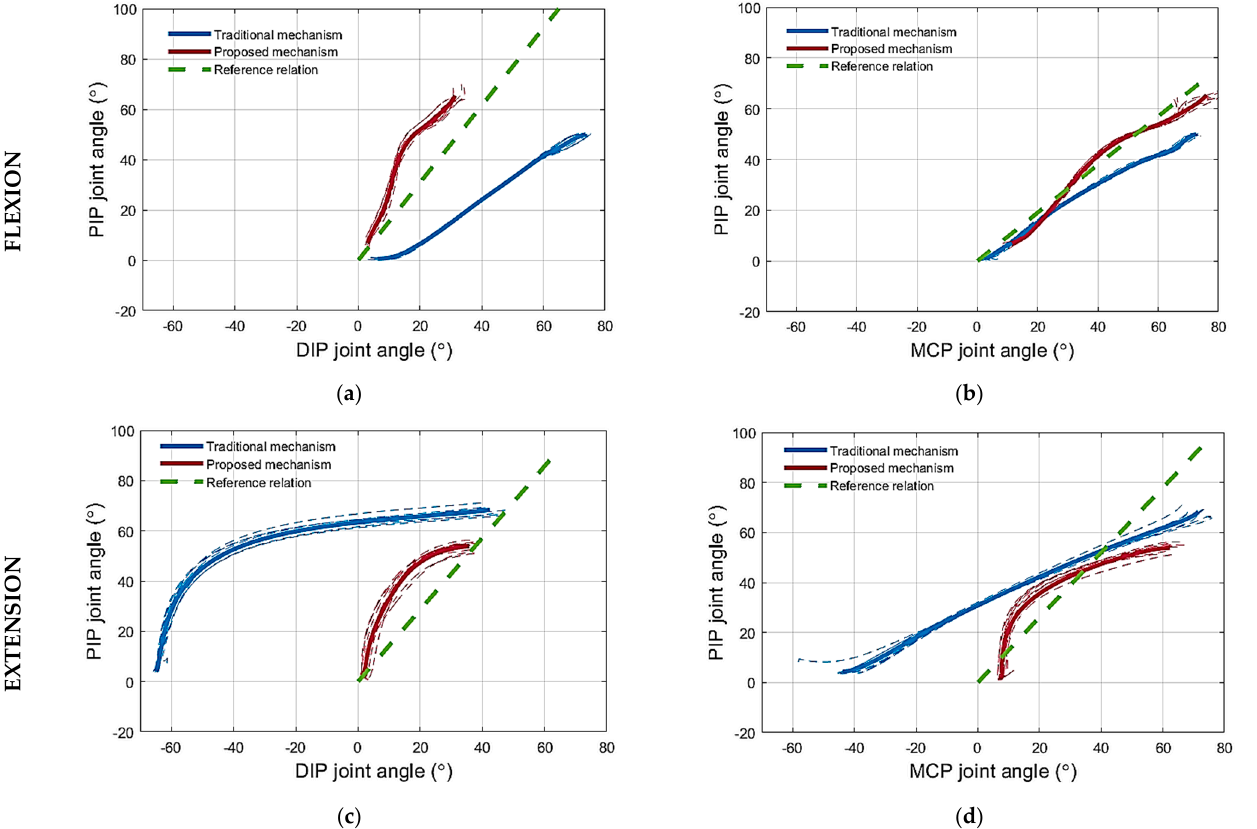
Figure 7. The phase plots for the finger joint angles during flexion and extension of the artificial finger using novel mechanism and traditional solution: ( a ) PIP–DIP joint angle relation during flexion; ( b ) PIP–MCP joint angle relation during flexion; ( c ) PIP–DIP joint angle relation during extension; ( d ) PIP–MCP joint angle relation during extension. Stippled lines are individual trials, and thick lines are the averages for the proposed (red) and traditional mechanism (blue). The dashed green lines are the reference inter-joint relations taken from the literature [29, 39].